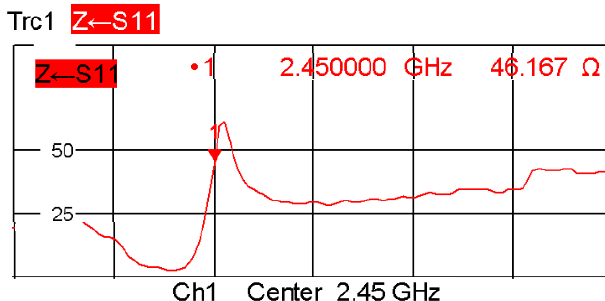
Figure 2: Measured impedance value of the proposed antenna.